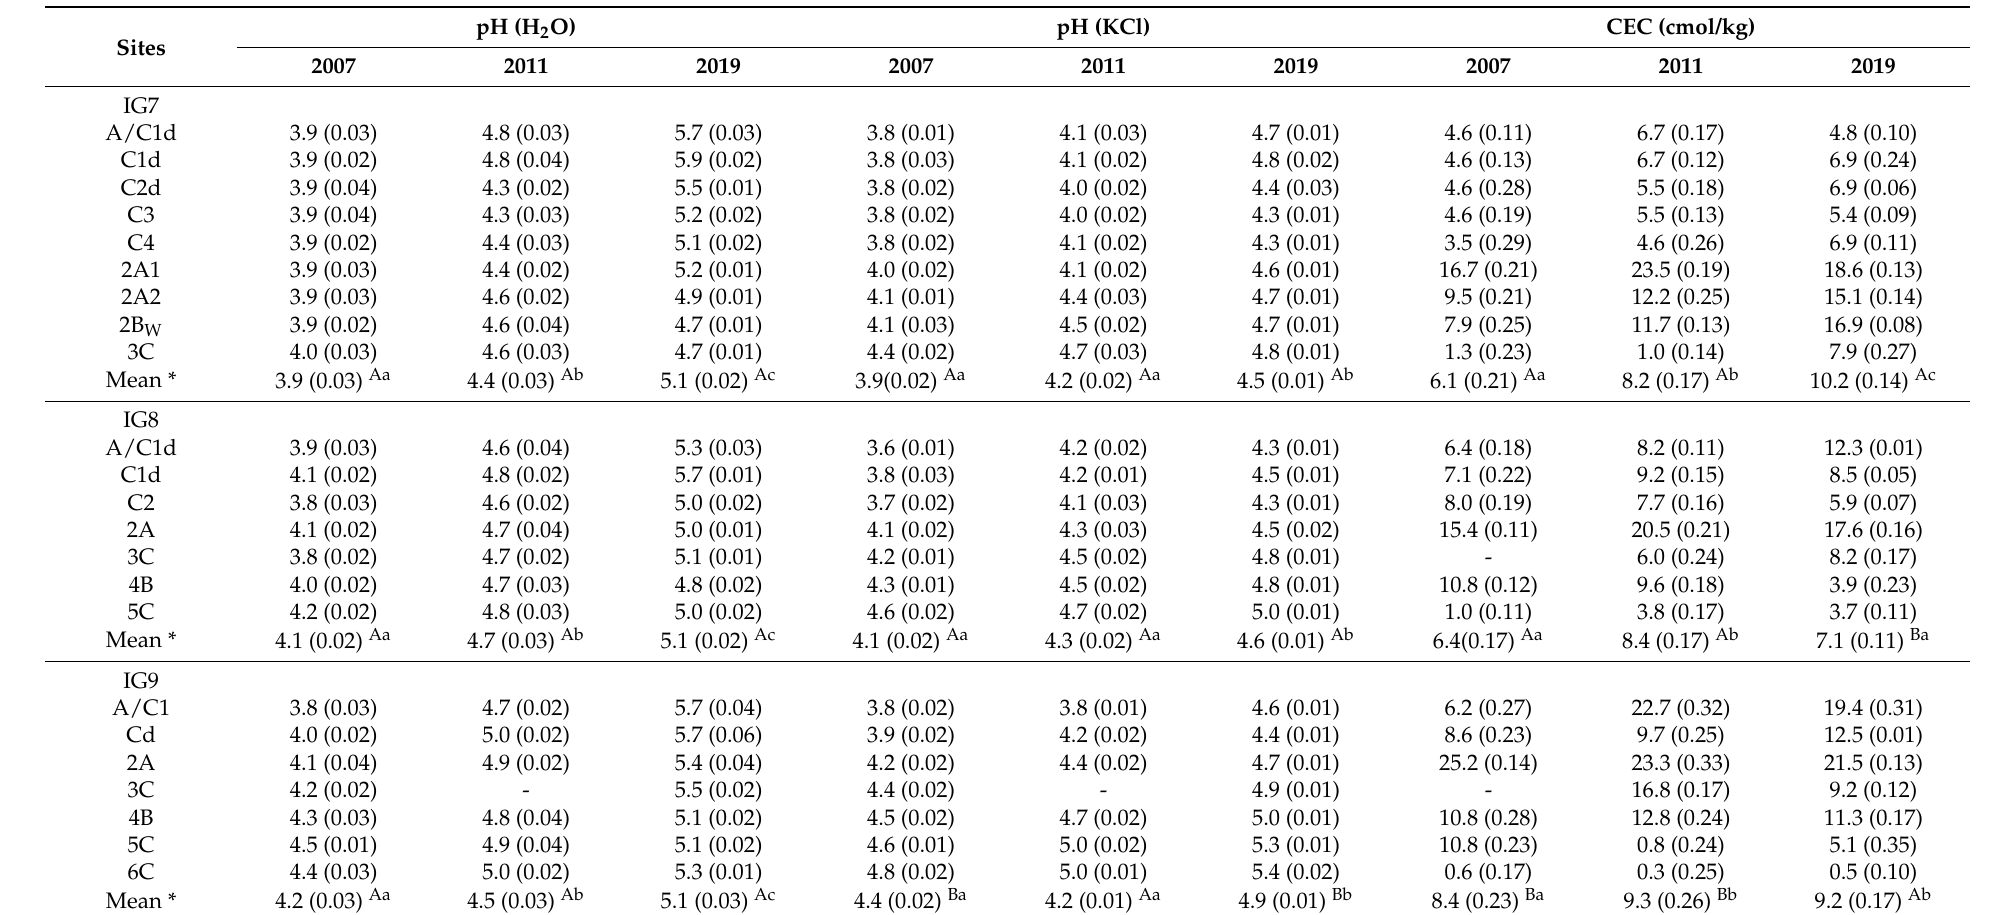
Table 3. pH and cation exchange capacity (CEC) at different sites (means and standard